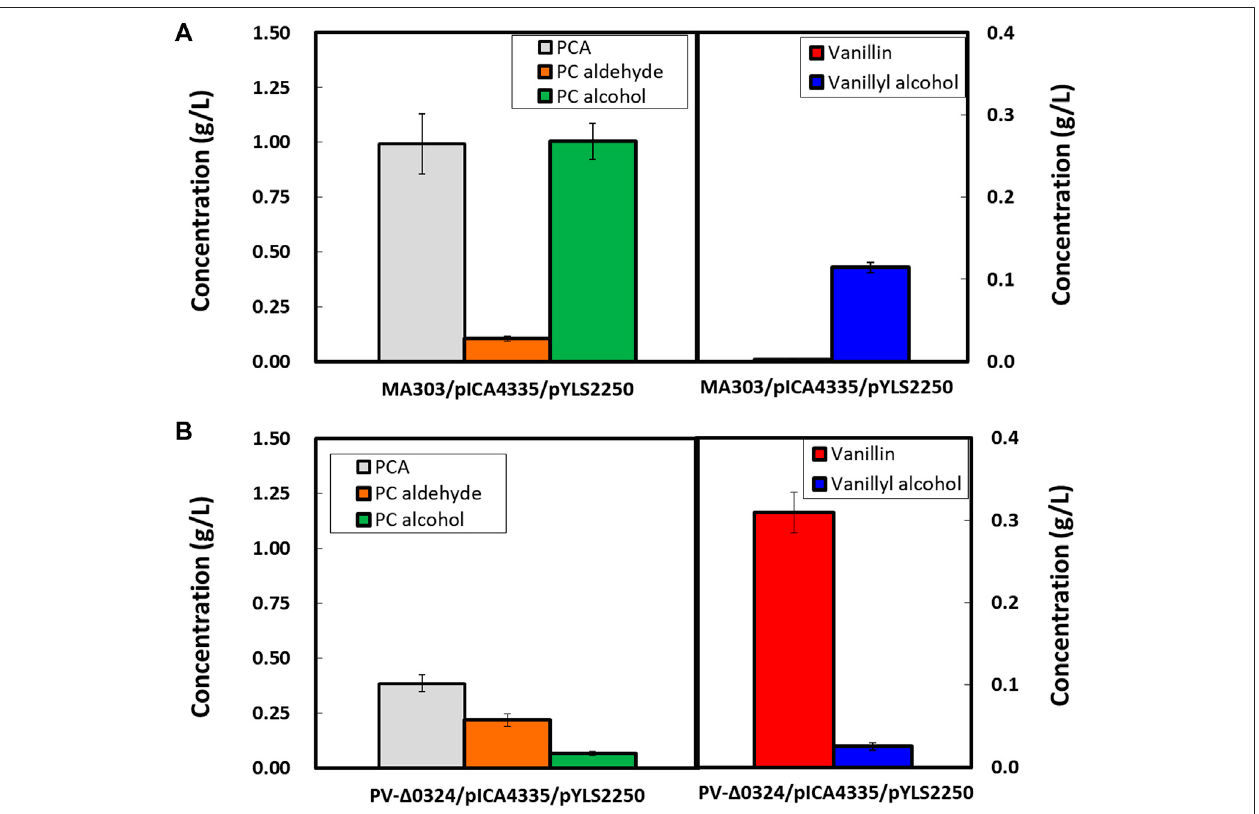
FIGURE 5 | Effect of NCgl0324 deletion on the production of vanillate, vanillin, vanillyl alcohol, protocatechuate, protocatechuic aldehyde, and protocatechuic alcohol by C. glutamicum mutants MA303 (A) and PV- Δ 0324 (B) harboring car -expressing pICA4335 and comt m -expressing pYLS2250 plasmids in fl ask culture. The cellsweregrownin fl askfermentationmediumsupplementedwith0.5 g/L L -methioninefor48 hat32 ° Cwithvigorousshakingat240 rpm.Meanandstandarddeviation of triplicate cultivation are given.